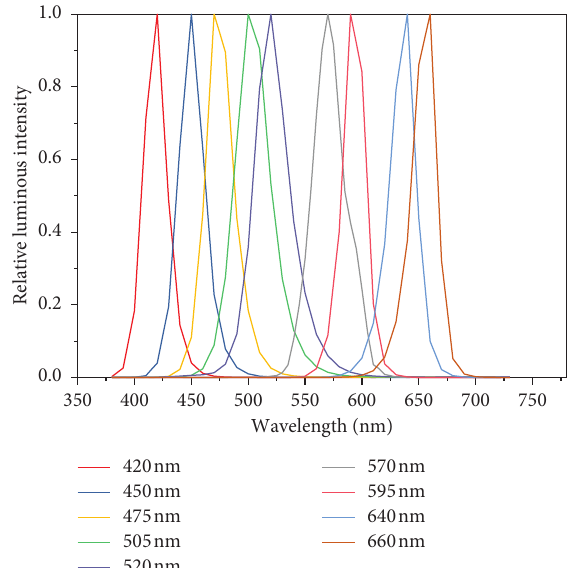
Figure 3: Relative luminance intensity of nine monochromatic LEDs.